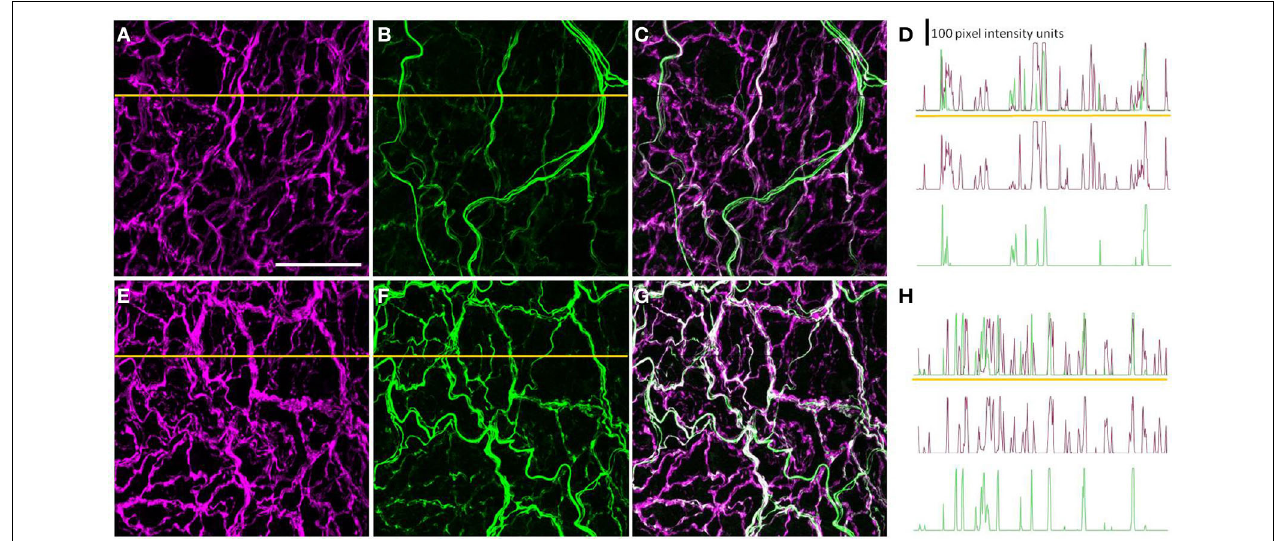
FIGURE 2 | Images showing immunolabeling for β -tubulin III (magenta; A,E) and peripherin (green; B,F) and the combination of both proteins (C,G) in the perivascular nerve plexus of a plantar metatarsal artery (PMA) from a control rat (A–C) and a streptozotocin (STZ)-treated rat (E–G) that received a low dose of insulin (STZ-LI). In comparison with the PMA from the control rat, the β -tubulin III-immunoreactive (IR) nerve fibers were thickened in the PMA from the STZ-LI rat. In addition, there was an